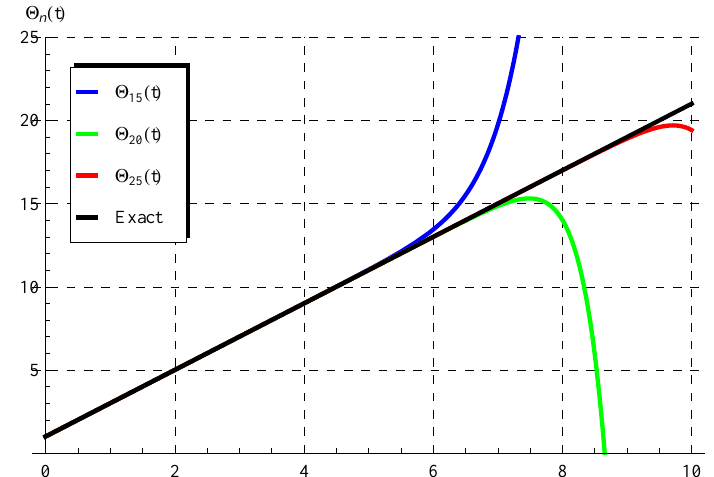
Figure 2. Comparisons between the approximate solutions Θ r ( t ) , r = 15,20, 25 in Equation (75) and the exact solution (72) at λ = , a = b = α = 1 ( c = − 1).